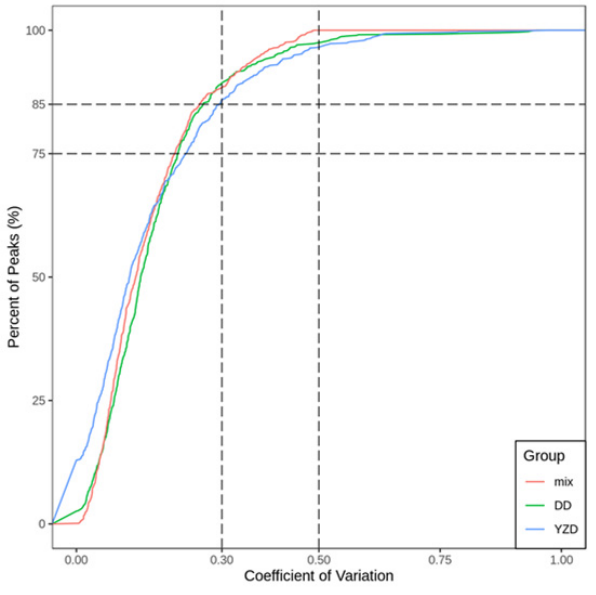
Figure 1. TIC overlapping figures of different QC samples (different colors represent different QC samples). ( A ) Negative ion mode. ( B ) Positive ion mode.